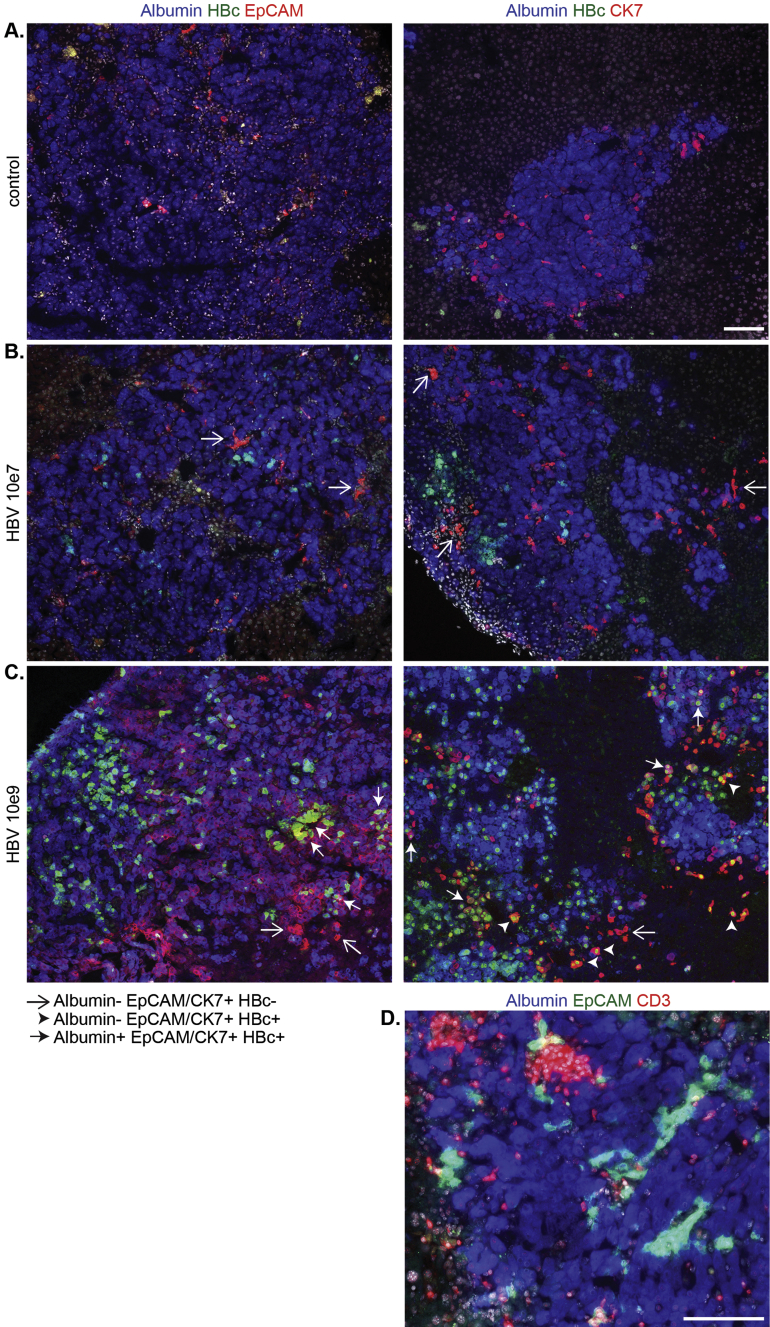
HBV-infected liver progenitor cells in highly viremic HIS-HUHEP mice. Immunofluorescence analysis of liver sections from (A) control, or HBV-infected mice inoculated with (B) HBV 10e7 or (C) HBV 10e9 for Albumin (blue), HBcAg (green) and either (left column) EpCAM (red) or (right column) CK7 (red). White open arrows show mono-stained cells for either EpCAM or CK7; white arrowheads show double-stained cells co-expressing HBc and CK7; white filled arrows show triple-stained cells co-expressing Albumin, HBc, and either EpCAM or CK7. (D) HBV-infected liver co-stained for Albumin (blue), EpCAM (green) and CD3 (red). Scale bar represents 100 μm.